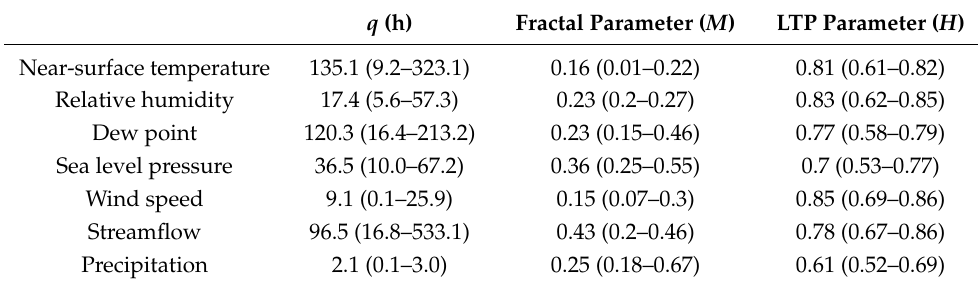
Table 3. Summary Statistics of the Scale, Fractal and Hurst Parameters of the Second-Order